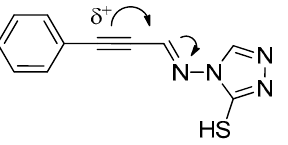
Figure 6. Polarization of the conjugate system of the compound 1a .